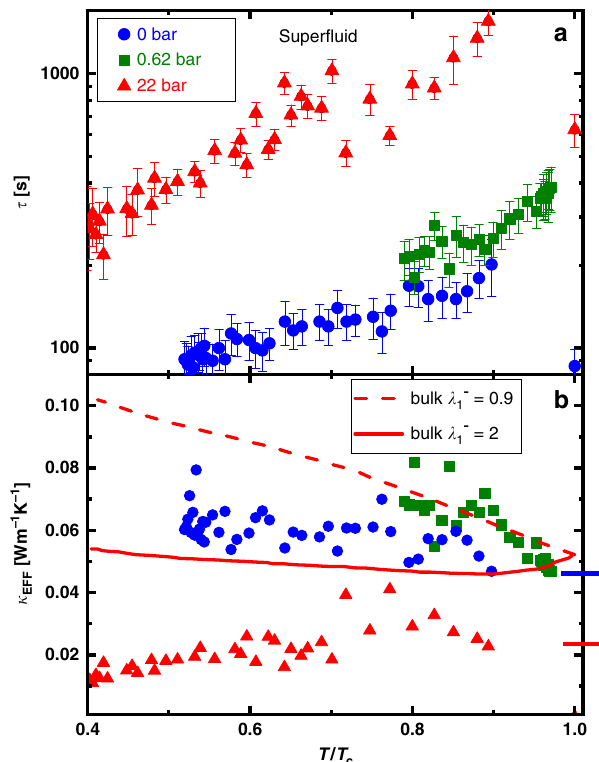
Fig. 5 Super fl uid state relaxation times and thermal conductivity. The measured thermal relaxation times ( a ) and calculated effective thermal conductivities, κ EFF ( b ) at 0 (blue circles), 0.62 bar (green squares), and 22 bar (red triangles) below the super fl uid transition temperature T c . The error bars represent the standard deviations of the fi ts to τ . The bulk calculations = 2 (red solid reference calculated thermal conductivity 47 at 21 bar with λ (cid:1) 1 line), = 0.9 (red dashed line), and should be compared to the 22 bar data. The blue (0 bar) and red (22 bar) horizontal lines mark the limiting ( T → T c ) value of κ EFF in the normal state (see Fig. 4), and are well below the bulk-like conductivity through this channel. In the bulk and under con fi nement, κ EFF is only weakly temperature dependent below T c . No calculations of κ ( T / T c ) exist in the literature for 0 effects in the 1.1 μ m channel below ~5 mK and at 22 bar below ~2.6 mK (near T c ).